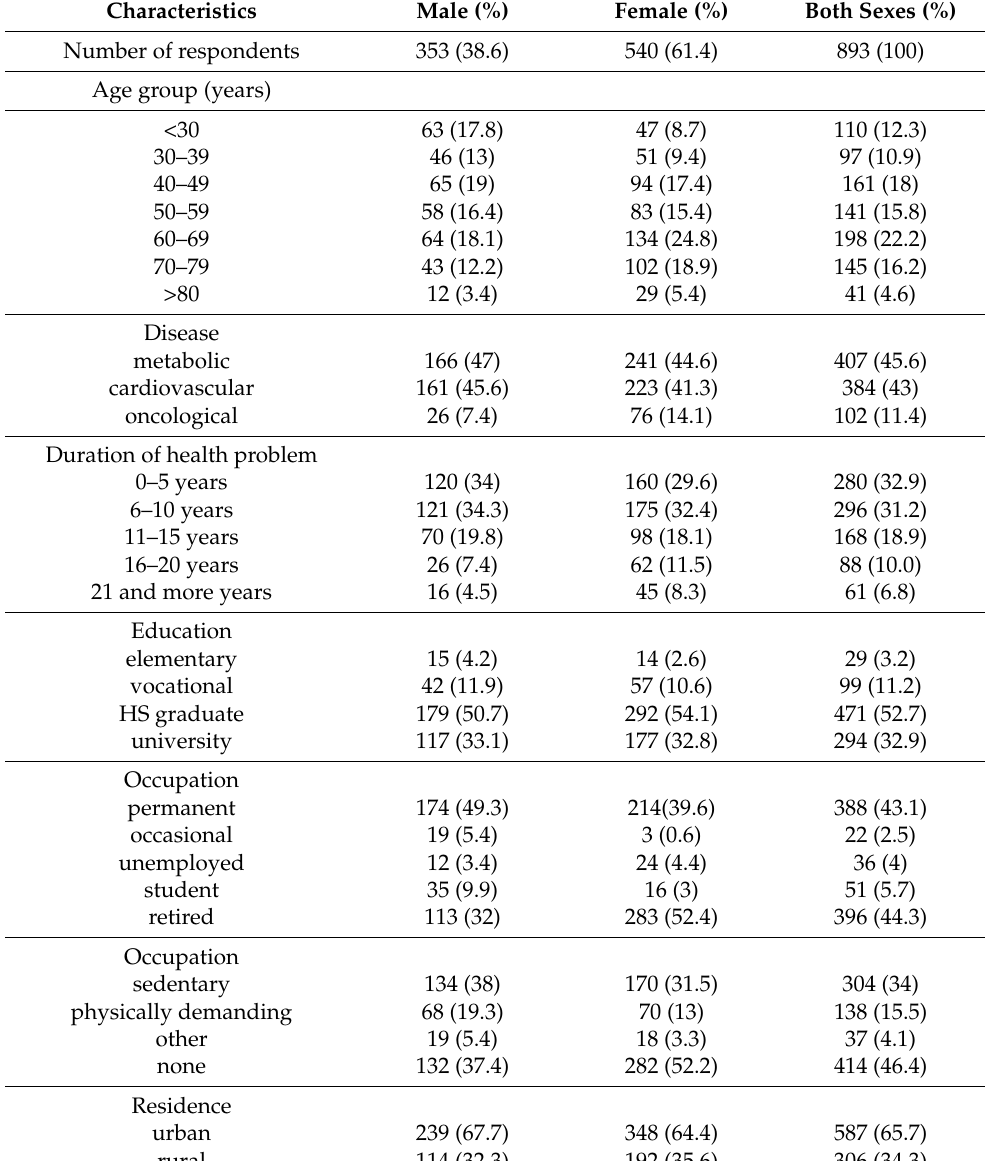
Table 1. Percentage distribution of patients by demographic characteristics and gender ( n =